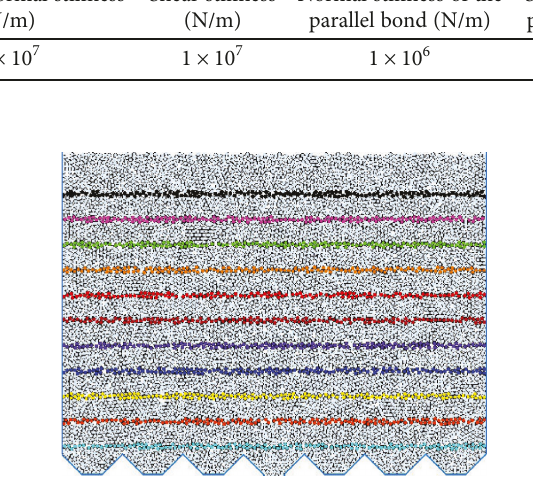
Figure 3: Layers of marked particles in the model.